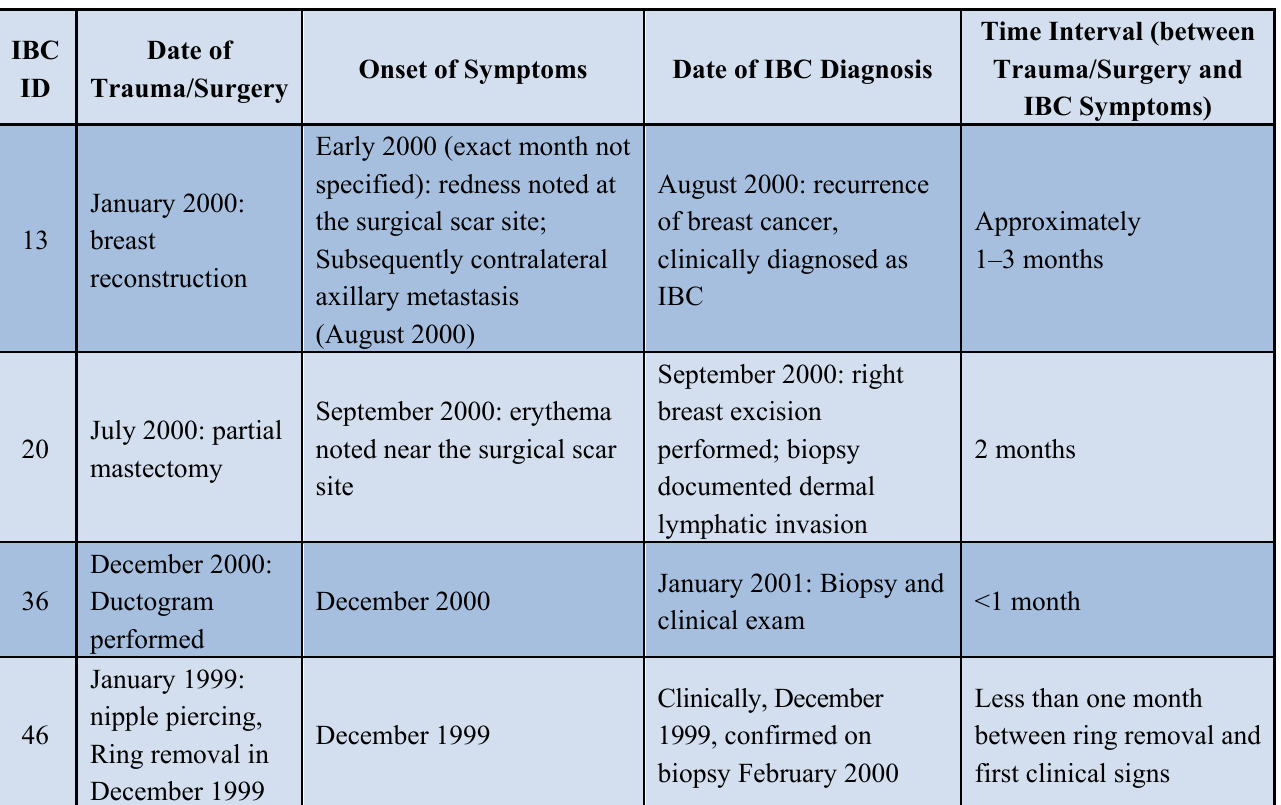
Table 1. Date of trauma/ surgery, onset of symptoms, IBC diagnosis and time interval between trauma and surgery and onset of